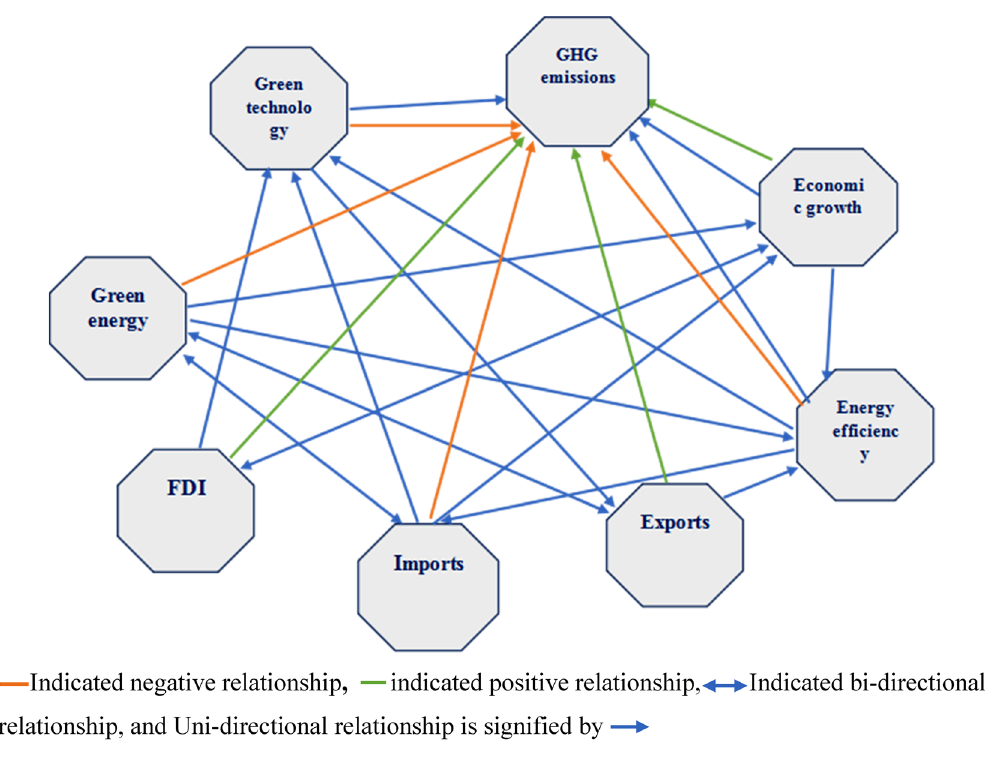
Figure 2. Geographical representation of